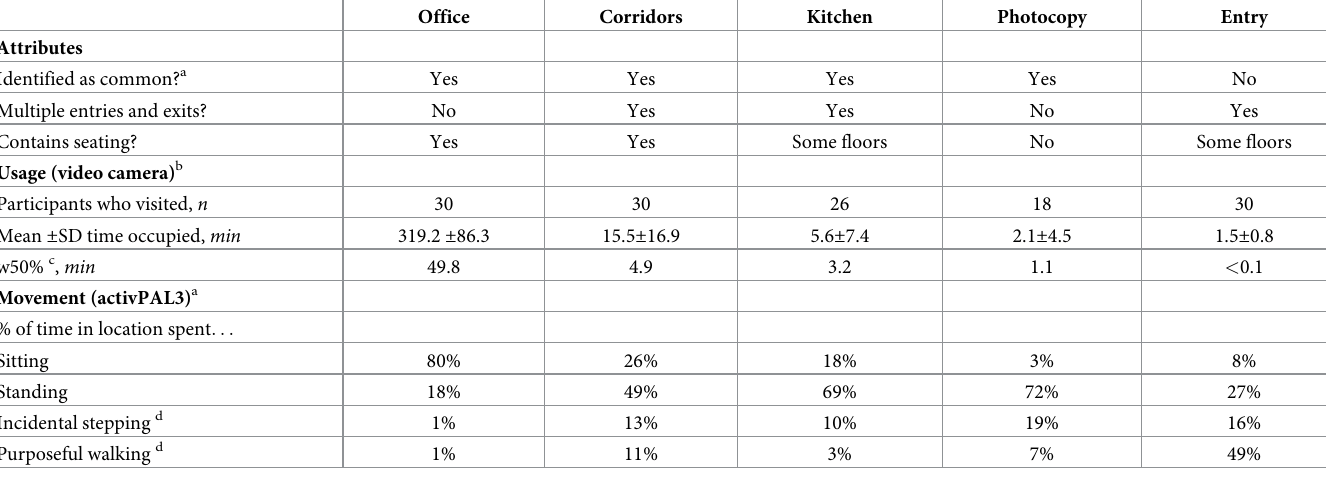
Table 1. Attributes, usage and movement within five common workplace locations (n = 30 participants).